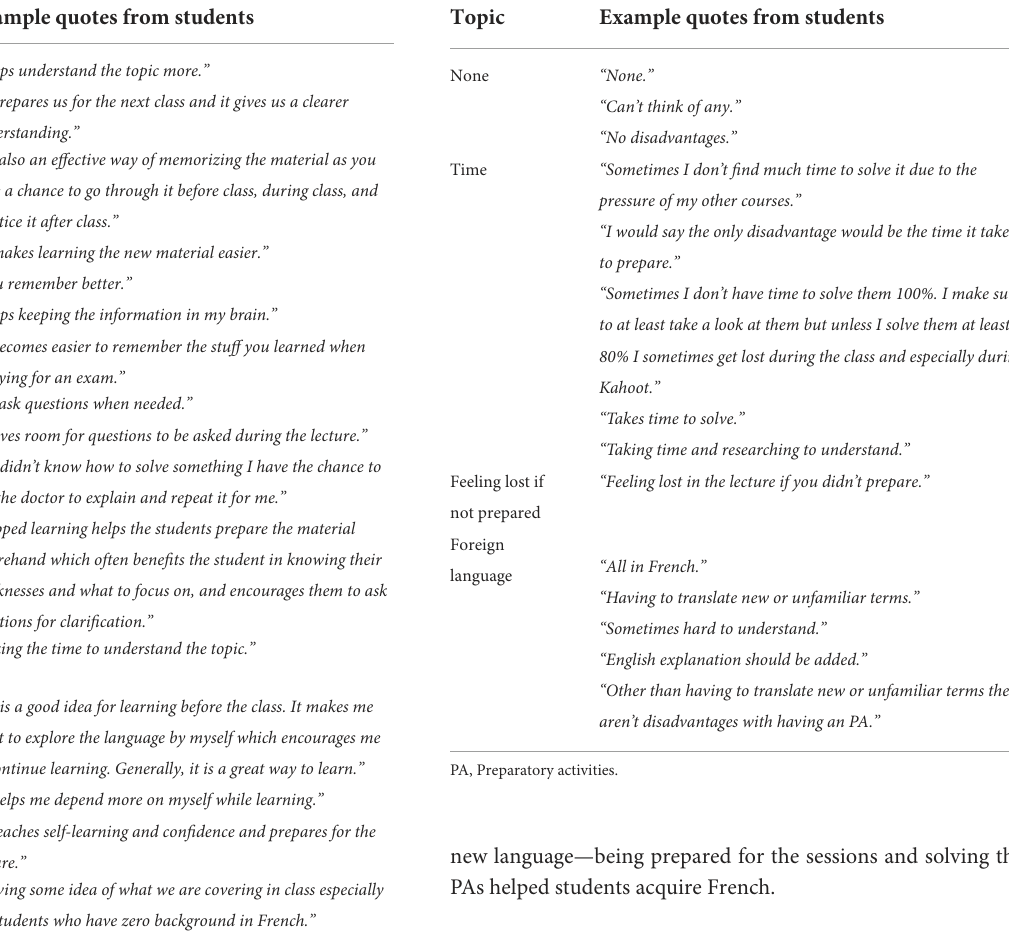
TABLE 5 Student answers to the question: What are the advantages of flipped learning (having PA to prepare)? Topic Example quotes from students